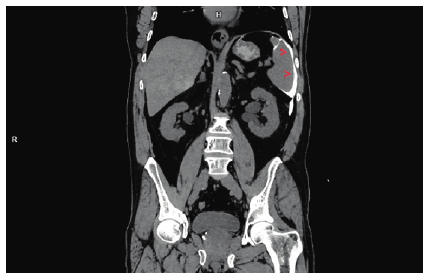
Figure 3: CT–free contrast around the gastric fundus and